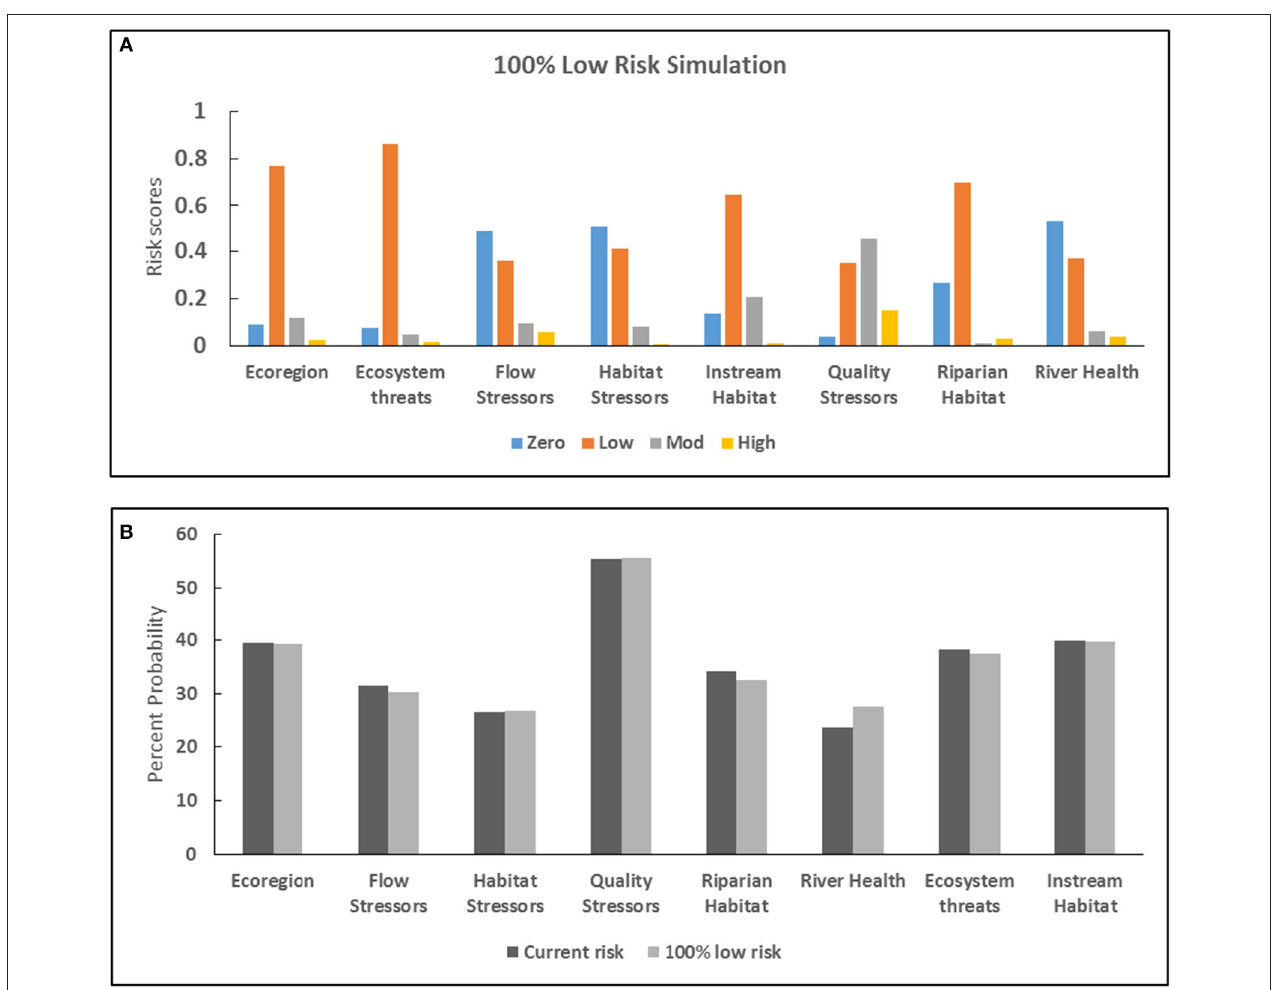
FIGURE 8 | Low risk simulation of KwaZulu-Natal rivers; (A) risk distribution for the low risk simulation, and (B) comparison between low risk and current risk